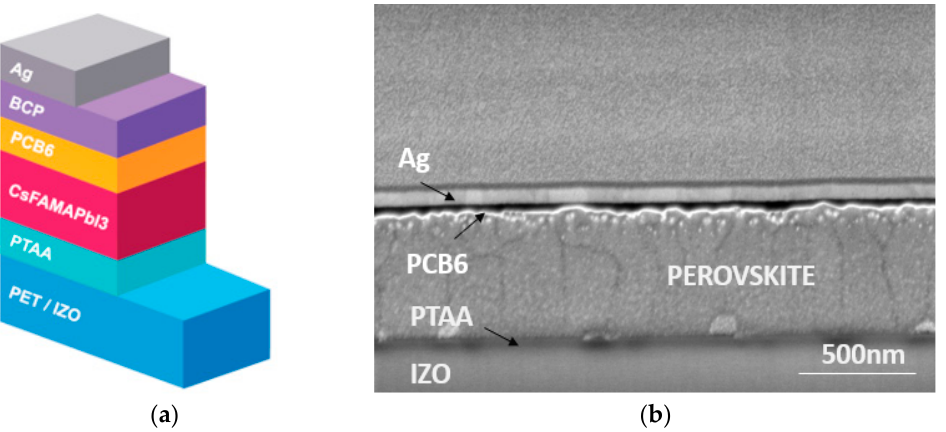
Figure 1. A cross section of the perovskite solar cell stack ( a ) and a SEM view of cross section ( b ). Table 1. Table describing the investigated samples. simulated AM1.5G irradiation (100 mW/cm 2 ) using an Sun 3000 AAA-rated solar